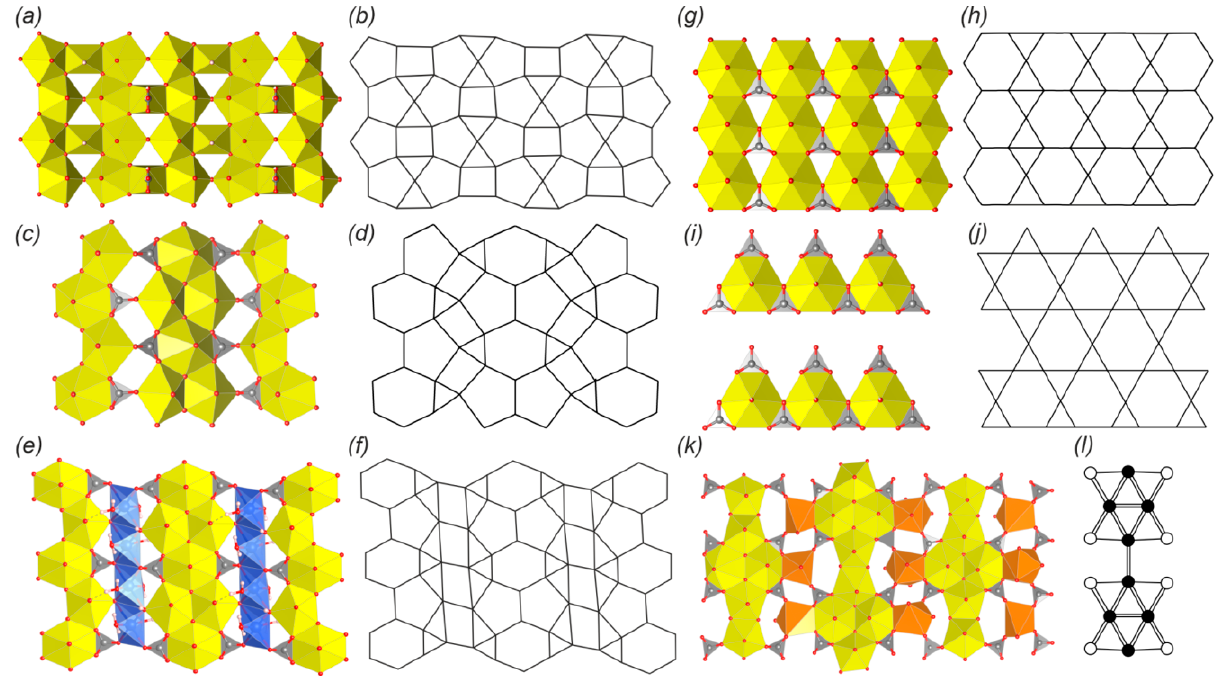
Figure 3. 2D complexes in the crystal structures of natural and synthetic uranyl carbonates and their anion topologies or graphical representation (see Table 1 and text for details). Legend: see Figure 1; Cu polyhedra = blue, Nd or Y polyhedra = orange; see Section 3.3 for details.